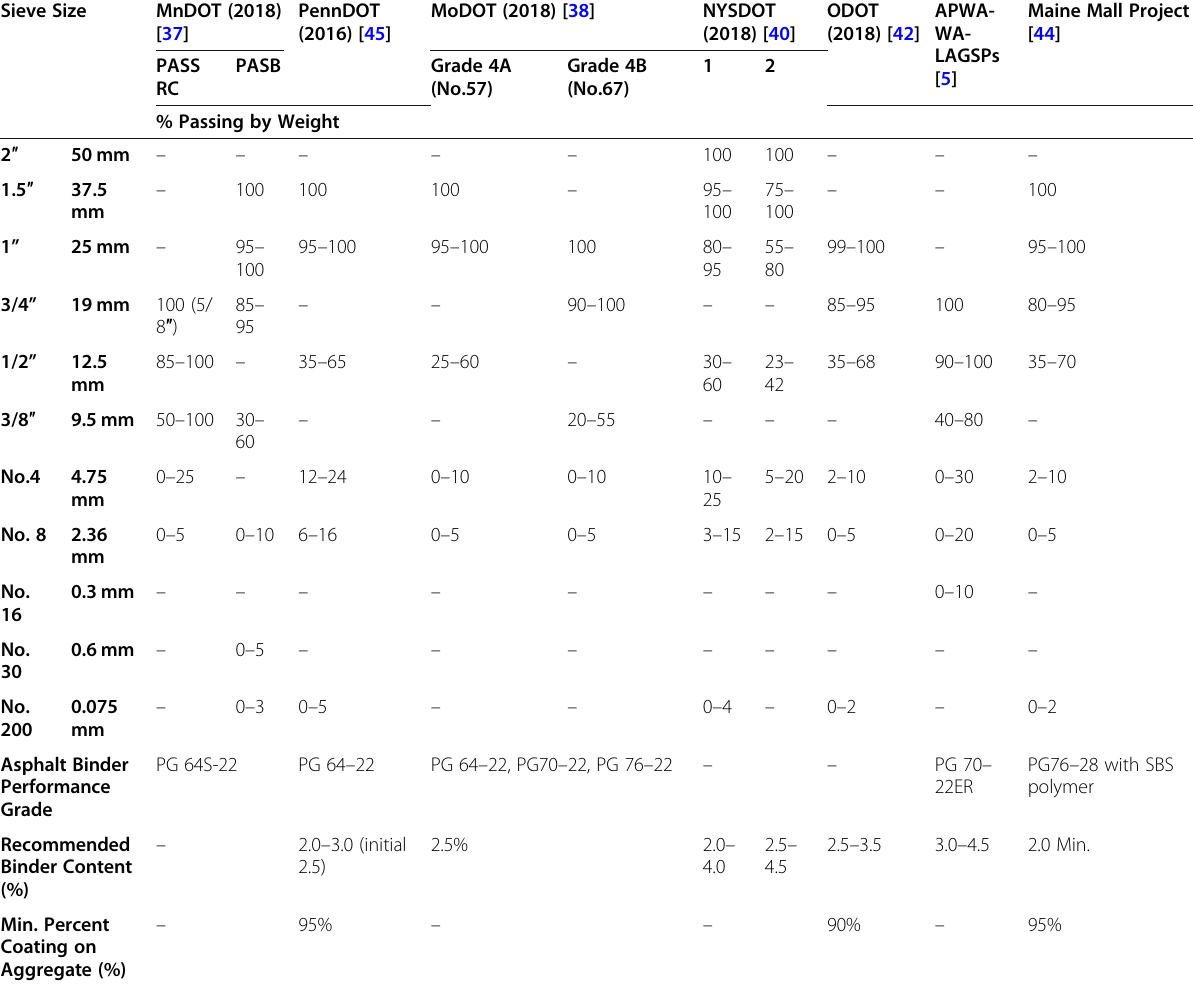
Table 3 Specifications for Mix Design of Asphalt Treated Permeable Base in the Northern States Sieve